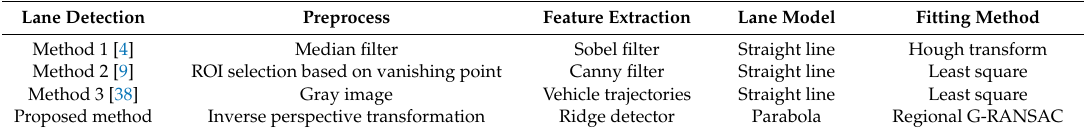
Table 6. Comparison of lane detection methods.